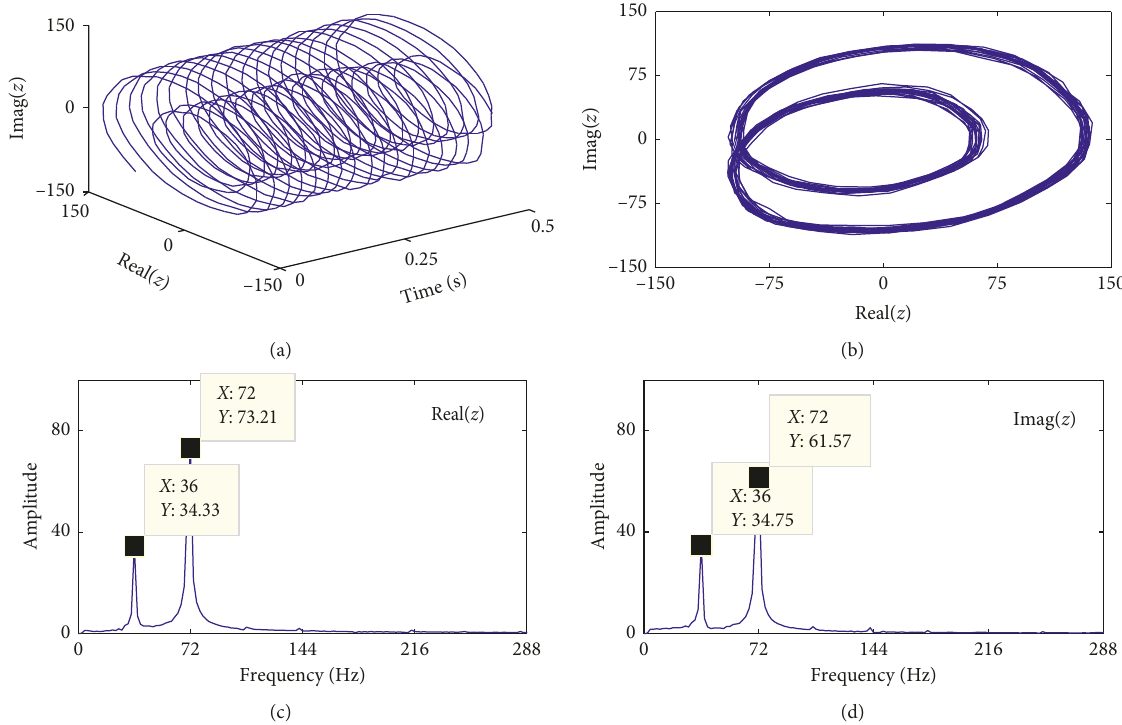
Figure 15: The oil whirl signal z : (a) the 3D time-domain wave of z ; (b) the 2D plane of z ; (c) the Fourier spectrum of Real[ z ]; (d) the Fourier spectrum of Imag[ z ].